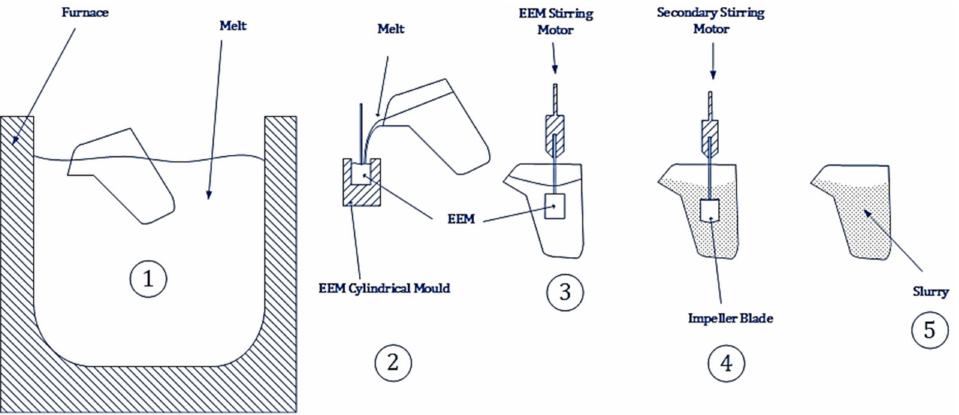
Figure 1. A Schematic illustration of the RheoMetal TM process with ( 1 ) scooping up metal from the furnace, ( 2 ) casting the EEM around the steel rod, ( 3 ) first stirring disintegrating the EEM, ( 4 ) the secondary stirring using an impeller for slurry conditioning and ( 5 ) the slurry ready for pouring into the shot